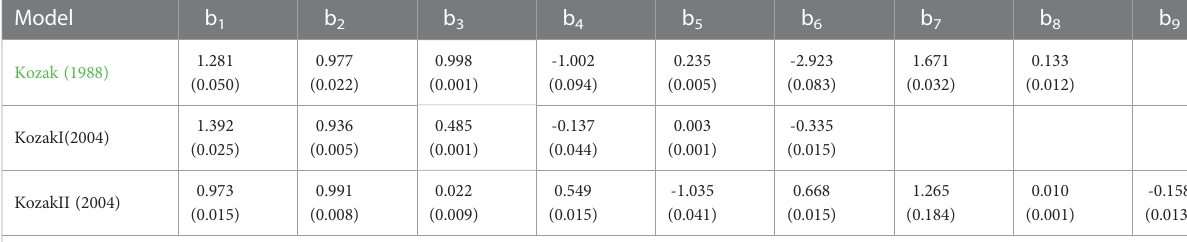
TABLE 2 Parameter estimates for three forms of Kozak ’ s variable exponential taper equations.